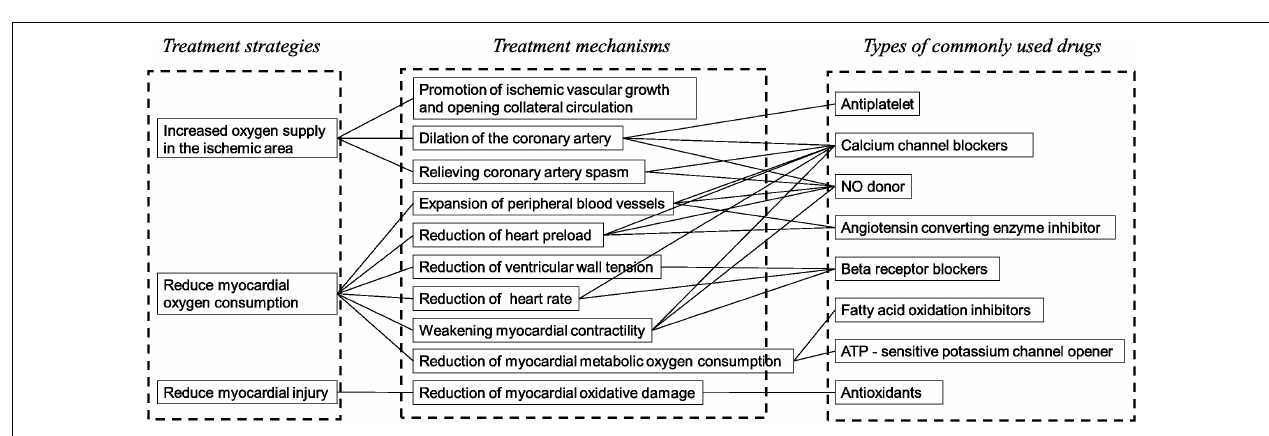
FIGURE 2 | The clinical strategies and related mechanisms for the treatment of AMI. From eight clinically common drugs used in the treatment of AMI, the major therapeutic strategies of AMI can be classified into three categories: increase of the oxygen supply in the ischemic area, reduction of myocardial metabolism and protection of myocyte. The effect for the evaluation of Schisandra in the treatment of AMI can be selected: dilation of the artery, decrease of the heart afterload, decrease of the ventricular wall tension, decrease of the heart rate, weakening of the myocardial contractility, decrease of the myocardial metabolic oxygen